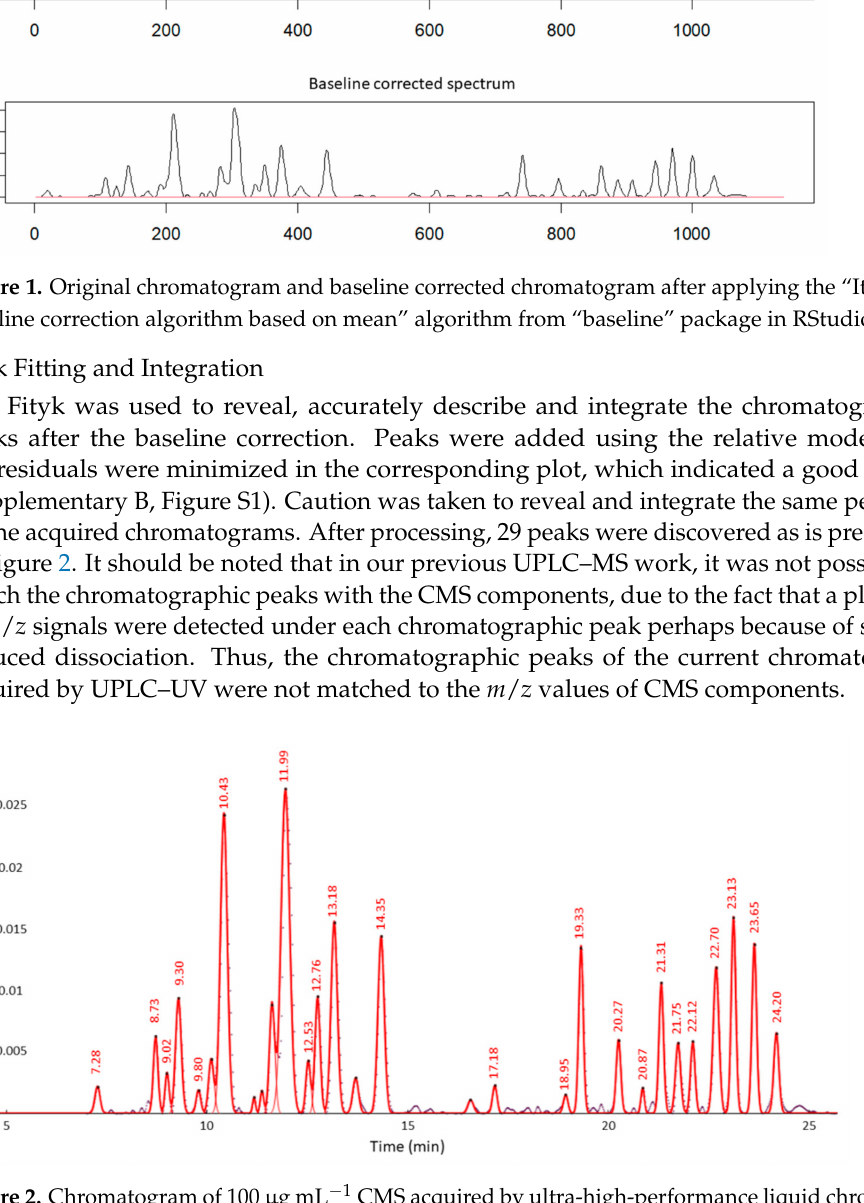
Figure 2. Chromatogram of 100 µ g mL − 1 CMS acquired by ultra-high-performance liquid chromatog- raphy coupled to a Waters ACQUITY UPLC™ Tunable UV (TUV) detector. 29 chromatographic peaks were discovered and integrated employing the free software Fityk (v. 1.3.1). The dataset points are presented by a dotted grey